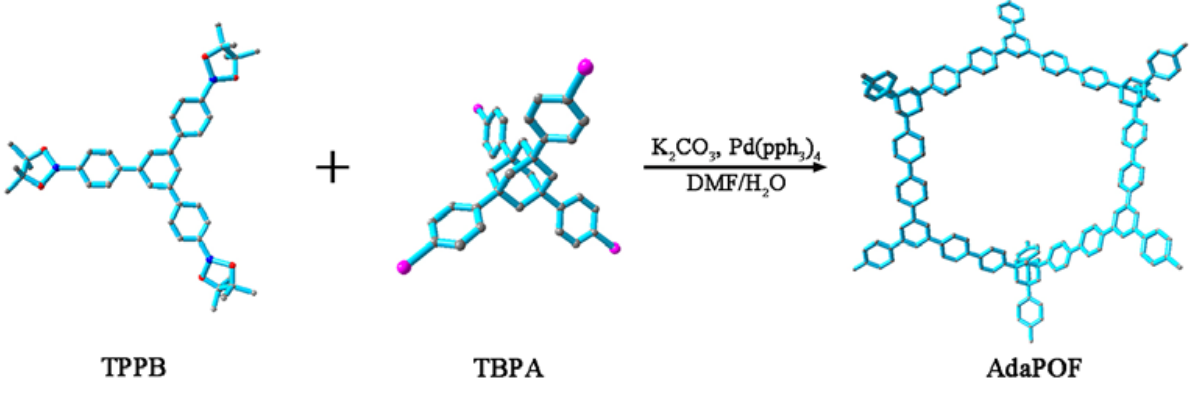
Figure 1. Synthesis routine of AdaPOF .